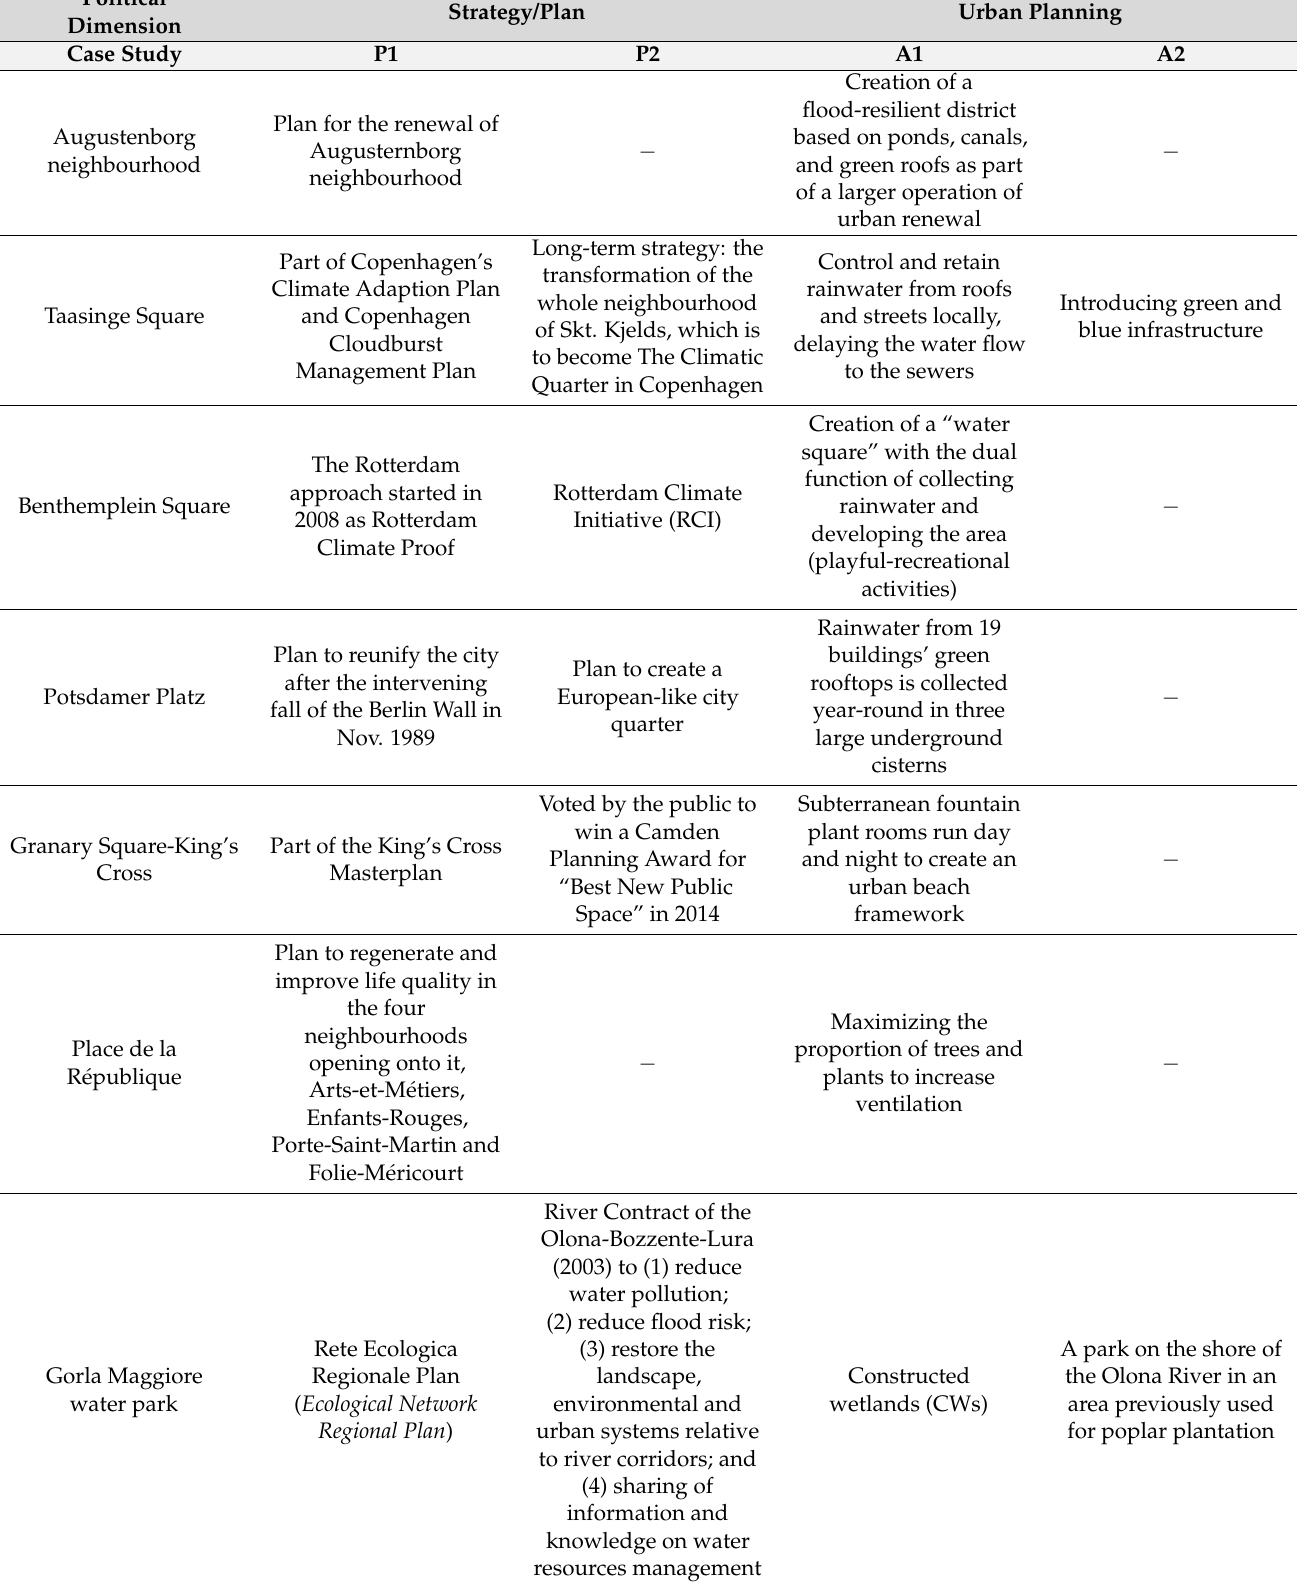
Table 3. The political dimension in case studies: Strategies and urban